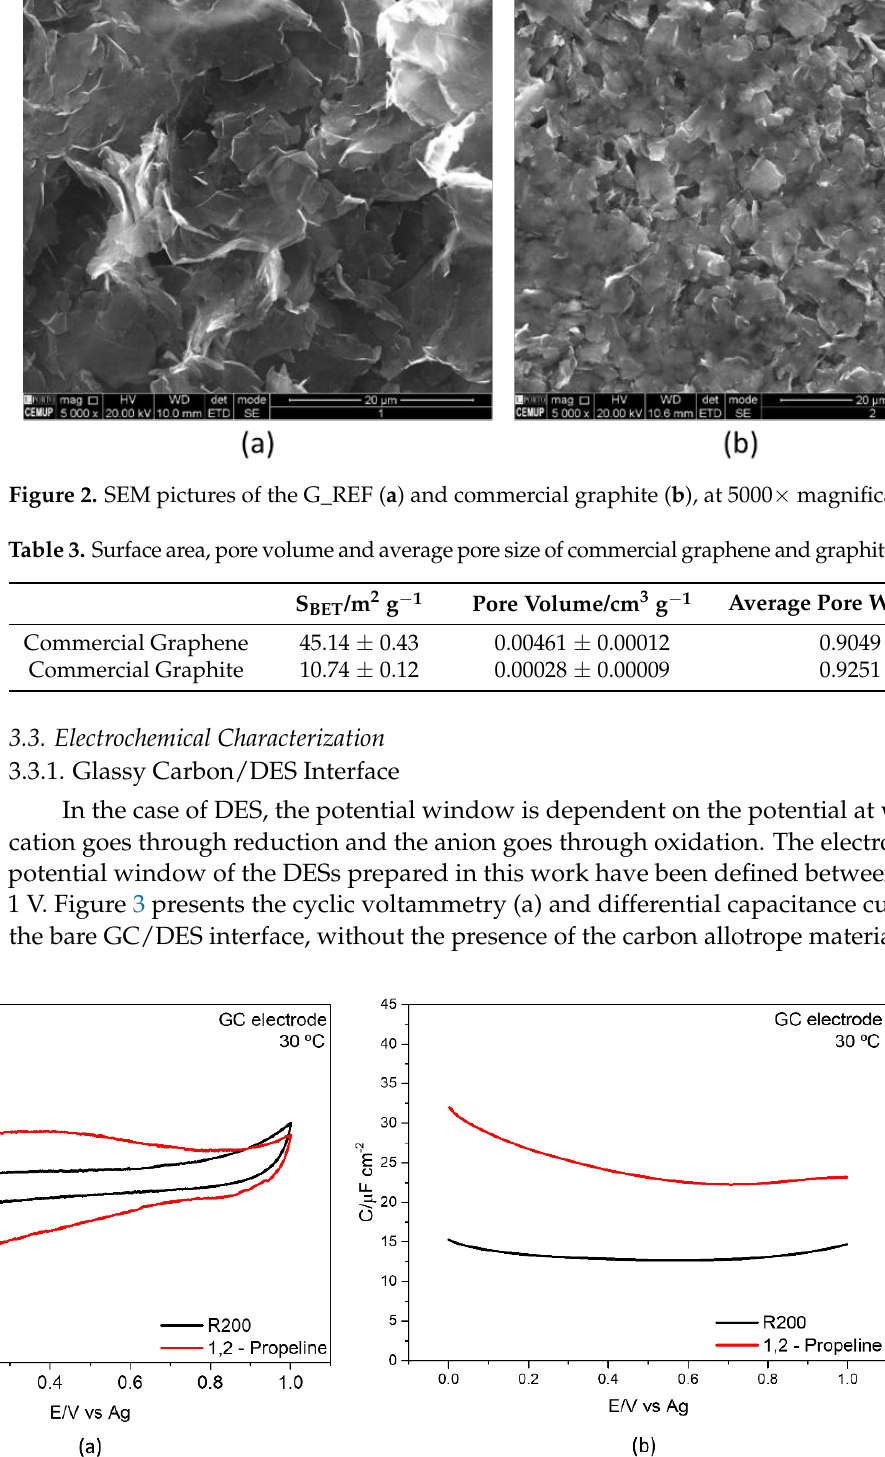
Figure 3. Cyclic voltammetry (scan rate of 50 mV s −1 ) ( a ) and differential capacitance curve (EIS) ( b ) measured at GC/DES interface at 30 °C. ( b ) measured at GC/DES interface at 30 ◦